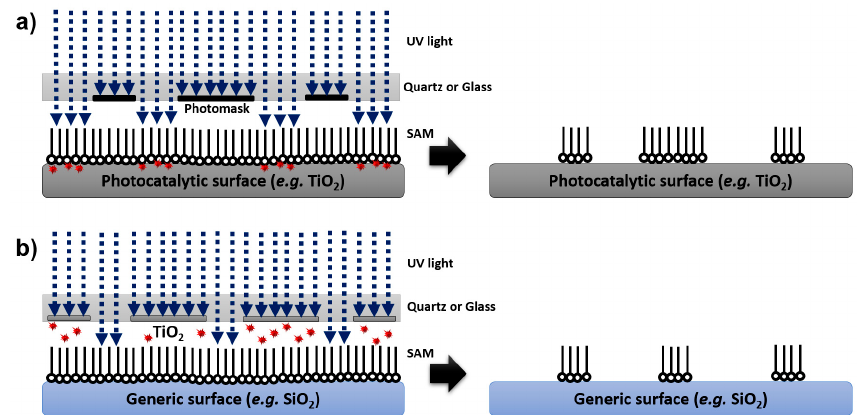
Figure 2. Schematic representation of direct ( a ) and remote ( b ) photocatalytic lithography for the patterning of a self-assembled monolayer (SAM). The photocatalytically-generated reactive oxygen species responsible for the patterning are represented as red stars. Adapted with permission from [15], Beilstein-Institut for the Advancement of Chemical Sciences,